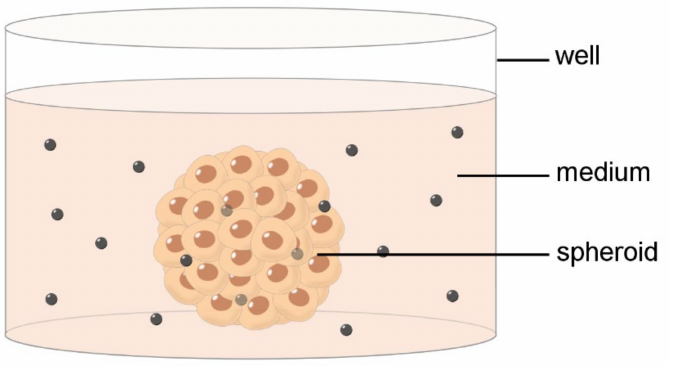
Figure 2. Schematic drawing of an in vitro 3D barrier model. Nanoparticles are administered in the medium and monitored for their penetration into the